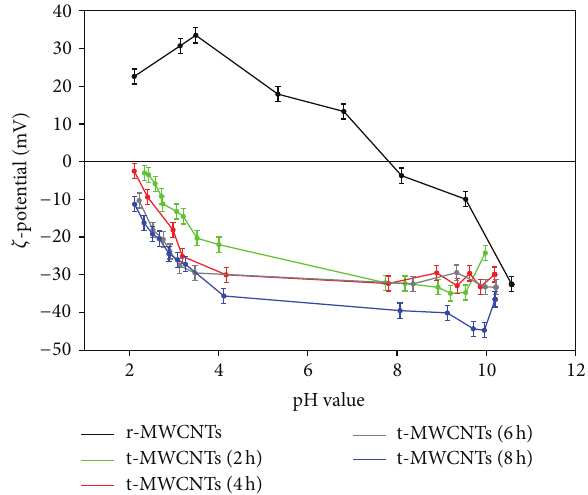
Figure 1: 𝜁 -potential of r-MWCNTs and t-MWCNTs as function of pH value and treatment time. Lines are guidelines for the eye